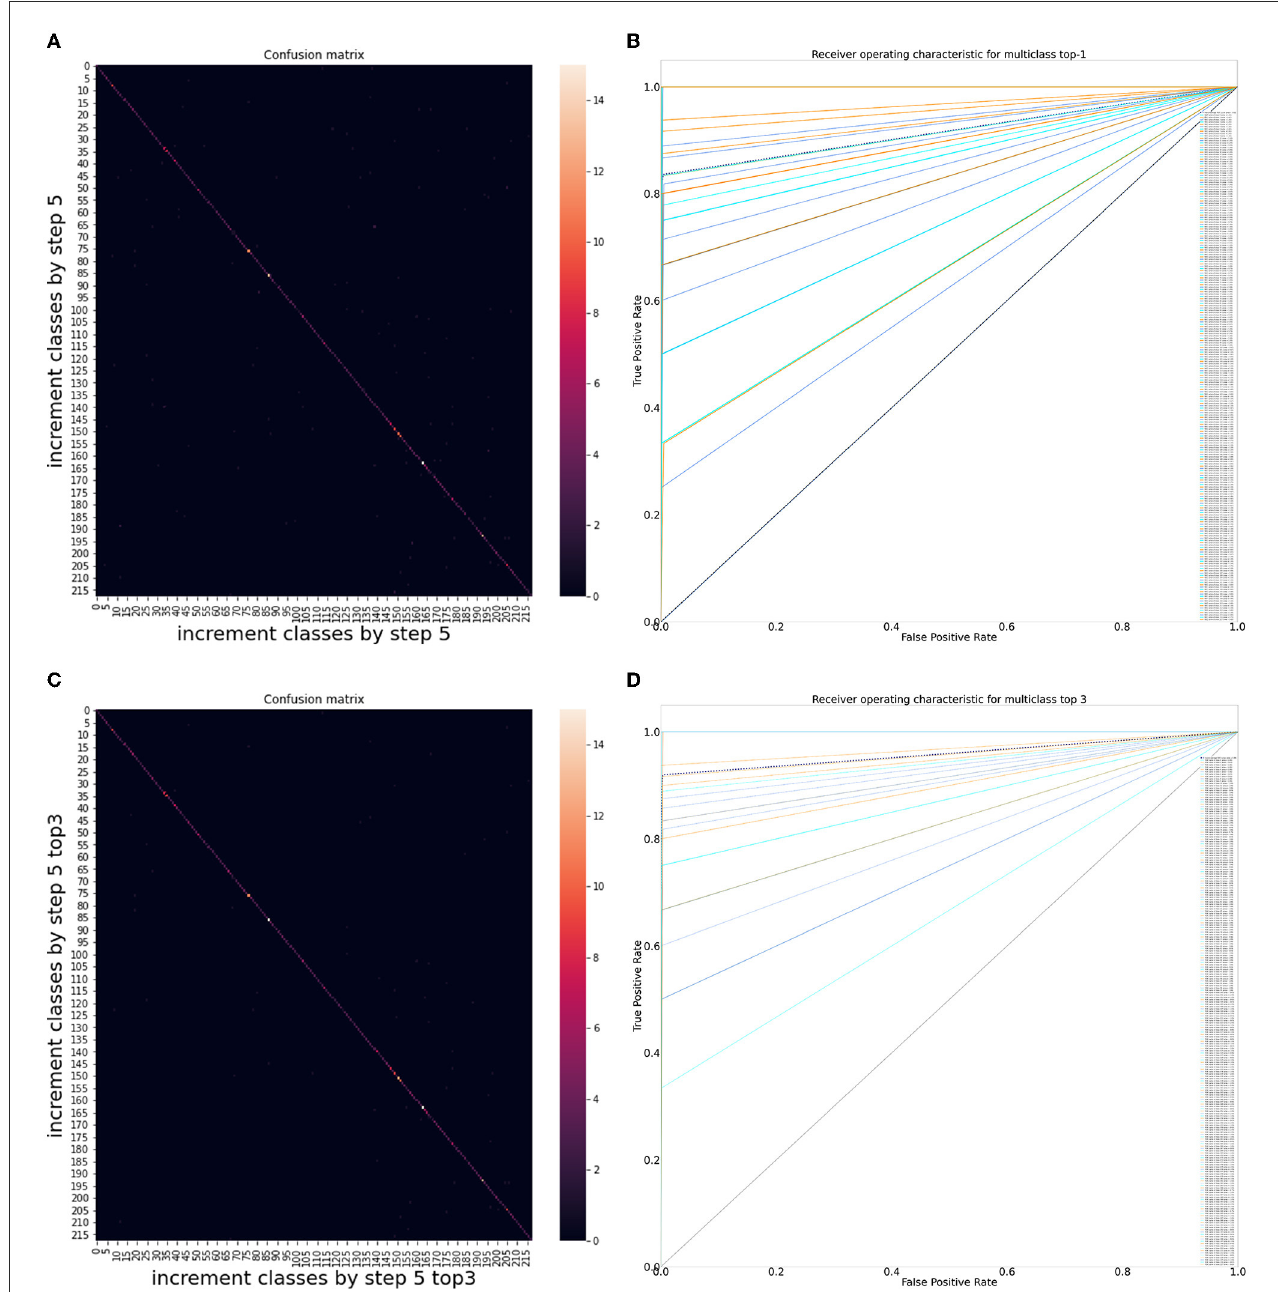
FIGURE3 Performance of DR-COVID, our multi-lingual Natural Language Processing (NLP)-based deep learning system. (A) Confusion matrix diagram of algorithm predictions for overall results. (B) Receiver Operating Characteristic (ROC) curve for overall results. The dotted black line shows the average performance of the system in achieving the correct corresponding standard answer, with an area under the ROC curve (AUC) of 0.917 [95% confidence interval (CI): 0.911–0.925], precision of 0.864 ± 0.193 [95% CI: 0.852–0.876], recall of 0.835 ± 0.218 [95% CI: 0.822–0.850], and F1 score of 0.829 [95% CI: 0.818–0.841]. (C) Confusion matrix diagram of algorithm predictions for top 3 results. (D) Receiver Operating Characteristic (ROC) curve for top 3 results. The dotted black line shows the average performance of the system in achieving the correct corresponding standard answer, with an area under the ROC curve (AUC) of 0.960 [95% CI: 0.955–0.964], precision of 0.938 ± 0.124 [95% CI: 0.931–0.946], recall of 0.920 ± 0.145 [95% CI: 0.910–0.929], and F1 score of 0.918 [95% CI: